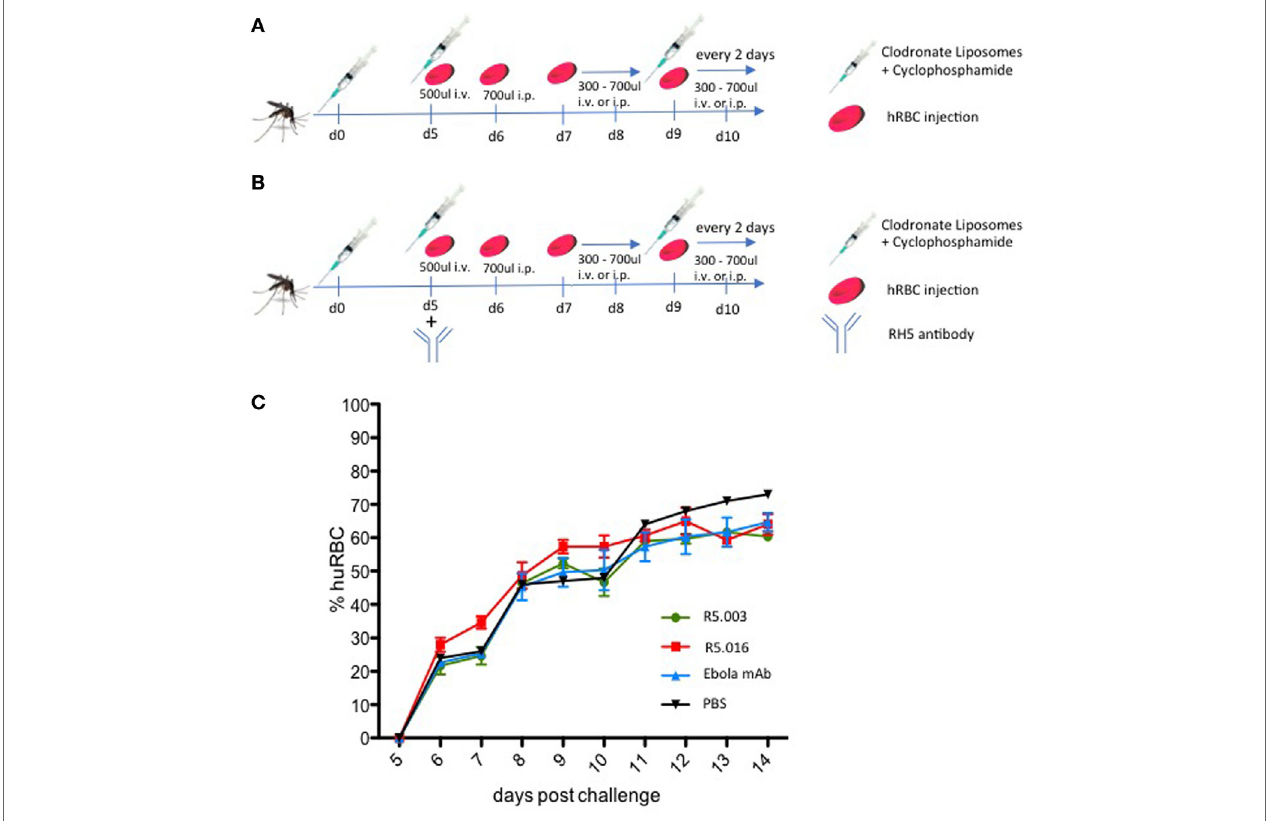
FIGURe 2 | Protocol for the repopulation of sporozoite-infected FRGN mice with human red blood cells (hRBCs). (A) Mice are infected by mosquito bite with Plasmodium falciparum NF54 GFP-Luc sporozoites ( n = 50 mosquitoes per mouse; 20 min). On the day of infection, mice are injected with 50 µl CloLip i.v. + 50 µl CloLip intraperitoneal (i.p.) and 150 mg/kg cyclophosphamide i.p. These injections are repeated on days 5, 9, 11, and 13 postinfection. On day 5 postinfection, 200 µl blood is drawn and the mice receive one injection of 500 µl hRBCs i.v. On day 6 postinfection, 100 µl blood is drawn and 700 µl hRBCs are injected i.p. The volumes of hRBCs injected the following days are determined individually in order to stabilize the percentages of hRBCs between 50 and 70%. (B) In order to assess the effect of antireticulocyte-binding protein homolog 5 antibody on transition and maintenance of a P. falciparum blood stage infection, blood humanization was achieved as described in (A) . On day 5 postmosquito-bite infection, all mice received one i.p. injection of 100 mg/kg of R5.003, R5.016, or control anti-Ebola monoclonal antibody (mAb) (EBL040). All three mAbs were human IgG1. One mouse received PBS as a control. (C) The percentages of hRBCs were assessed by FACS analysis using a CD235ab antibody. All mice show similar percentages of hRBCs throughout the 14-day observation period, independent of the treatment regimen, demonstrating that the differences observed in blood stage infection were not due to varying amounts of hRBCs. The mean ± SD is shown for each treatment